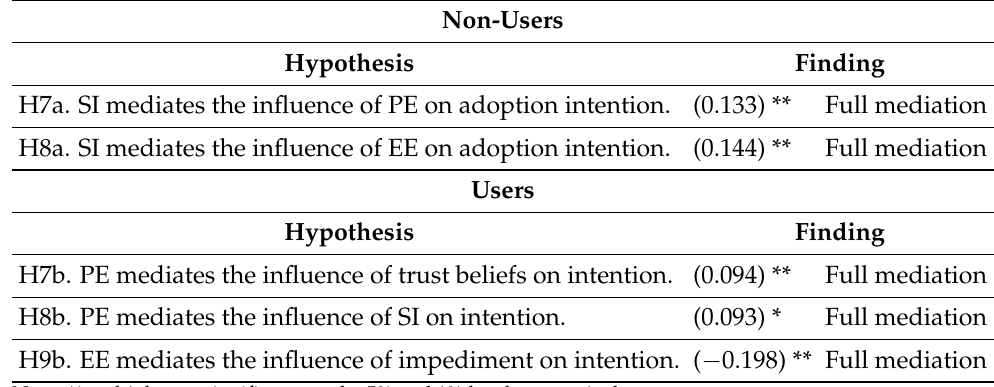
Table 4. Mediation